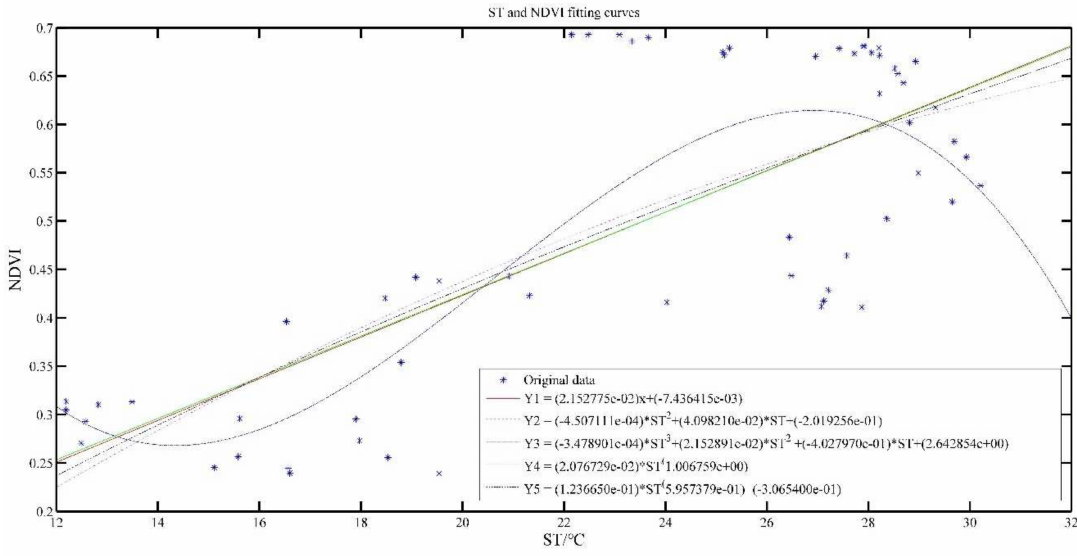
Figure 4. ST and NDVI model